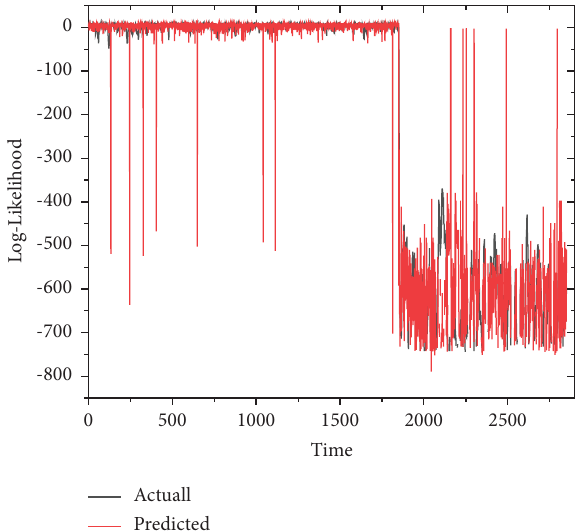
Figure 15: Detection and prediction result of CSTR process fault.